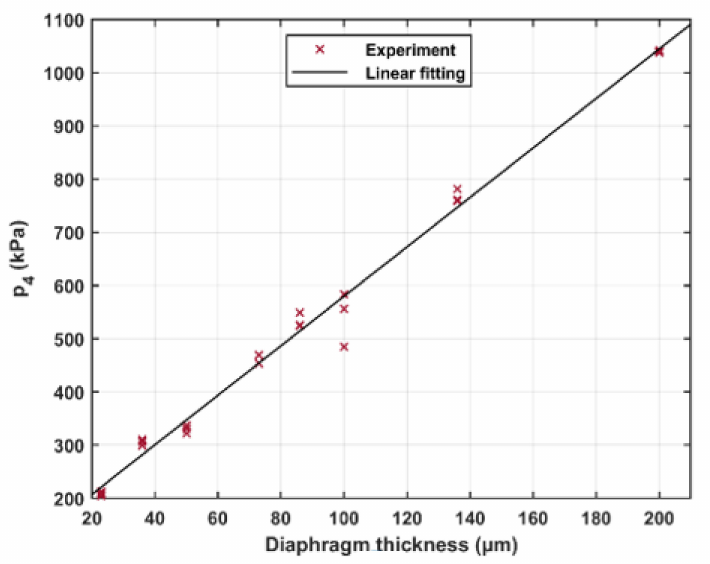
Figure 8. The bursting pressure of the single diaphragm as a function of the diaphragm thickness; p 1 is 100